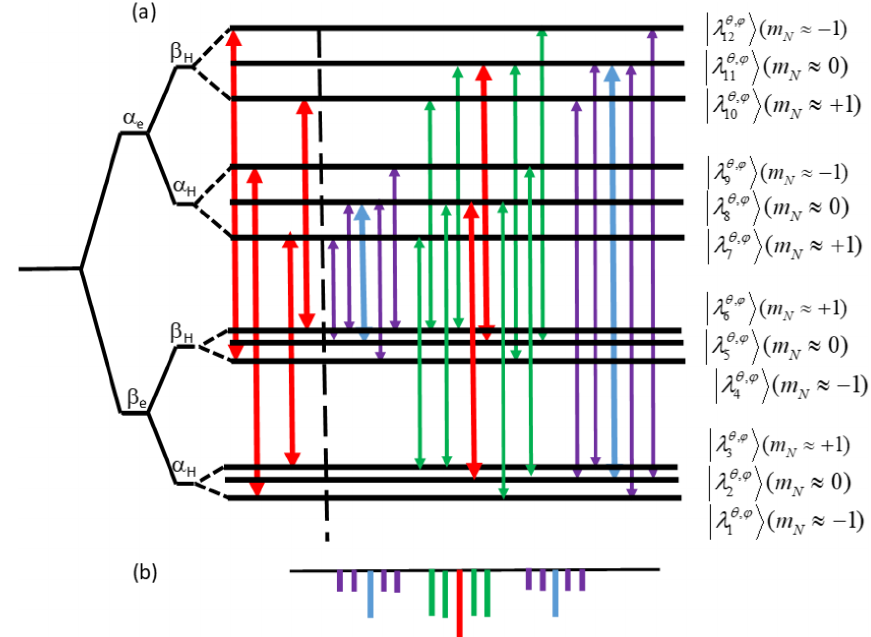
Figure 2. (a) A schematic energy level diagram of the three spin system with angles ( θ , φ ), corresponding to an allowed transition. The (cid:12) (cid:69) (cid:12) λ θ,ϕ eigenstates are characterized by their m N values and product states of | χ e (cid:105) , | χ H (cid:105) and | χ N (cid:105) . The energy level differences ν e and (cid:12) i ν H ± A H are scaled arbitrarily. On the left of the energy level diagram the allowed transitions (3–7), (6–10), (1–9) and (4–12) are indicated by the red arrows. On the right the red arrows correspond to the allowed transition between the states with subindexes (2–8) and (5–11). The nitrogen forbidden transitions (2–9), (2–7), (4–11) and (6–11) are assigned by the green arrow and the proton forbidden transitions (2–11) and (5–8) by the blue arrows. The purple arrows indicate the combined proton–nitrogen transitions. (b) A schematic presentation of the ELDOR spectrum corresponding to overlapping allowed (2–8) and (5–11) transitions following the color coding of the